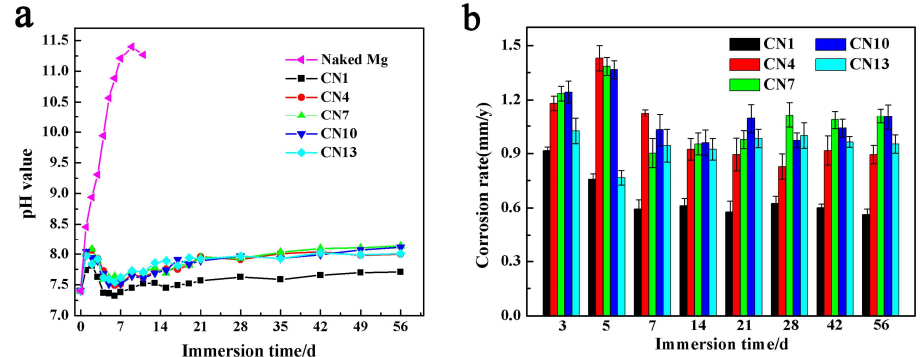
Figure 7. Di ff erent Ca-P coating samples (and naked AZ31 alloy) after immersion in SBF for di ff erent Figure 7. Different Ca-P coating samples (and naked AZ31 alloy) after immersion in SBF for different time nodes: ( a ) pH values of SBF solution; ( b ) average corrosion time nodes: ( a ) pH values of SBF solution; ( b ) average corrosion rates.